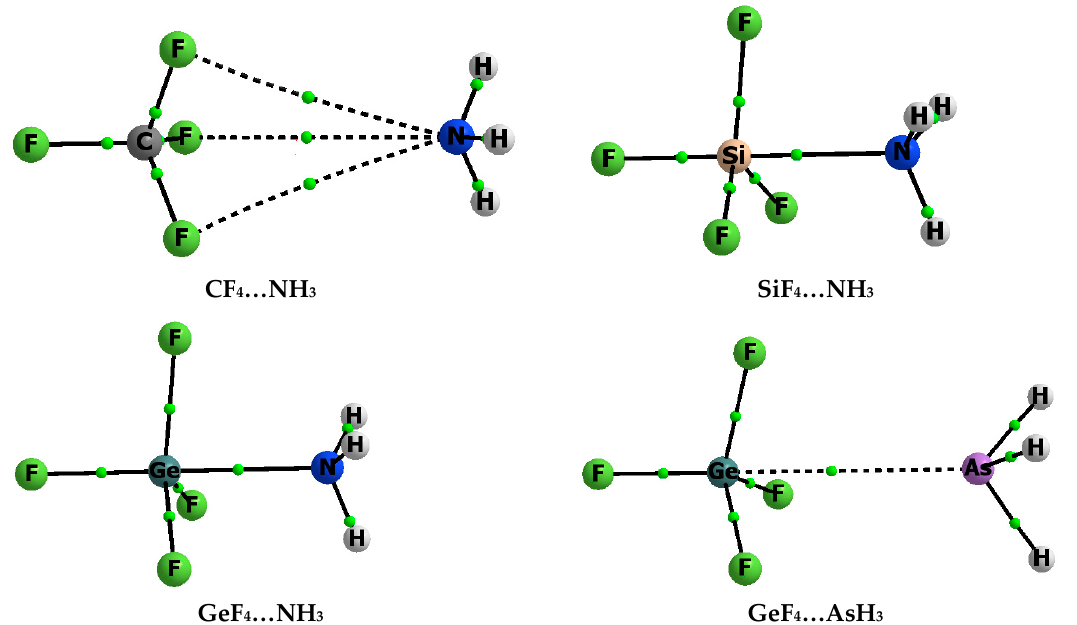
Figure 1. Molecular graphs of complexes containing one ligand (NH 3 or AsH 3 ); attractors are designated by big circles while bond critical points by small ones, and continuous and broken lines correspond to bond paths.